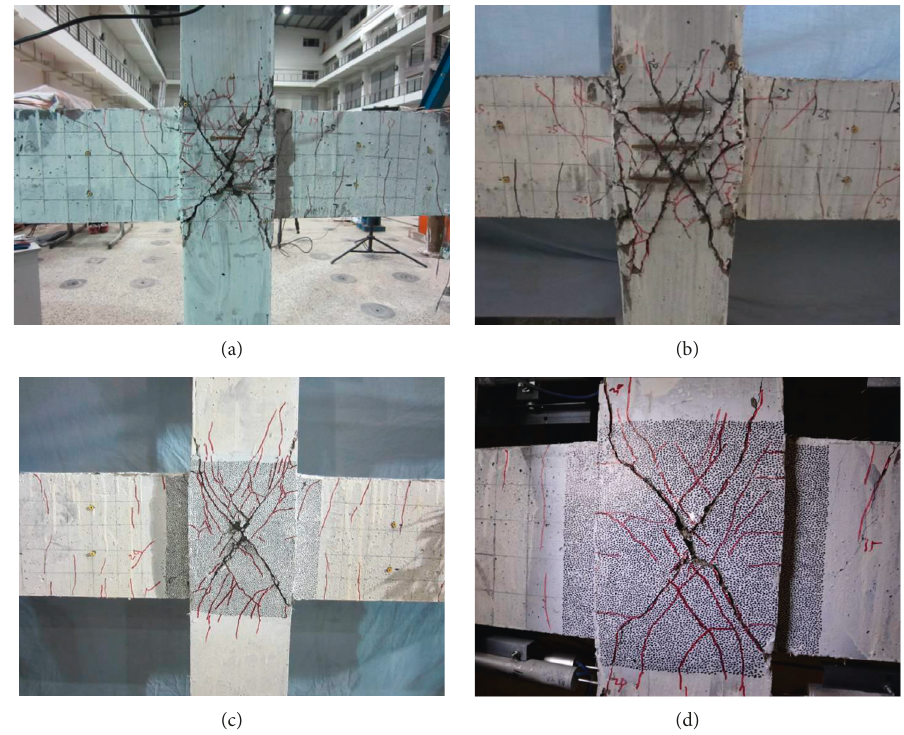
Figure 5: Failure mode of joints. (a) Specimen J-0-0.3. (b) Specimen J-0-0.5. (c) Specimen J-1-0.3. (d) Specimen